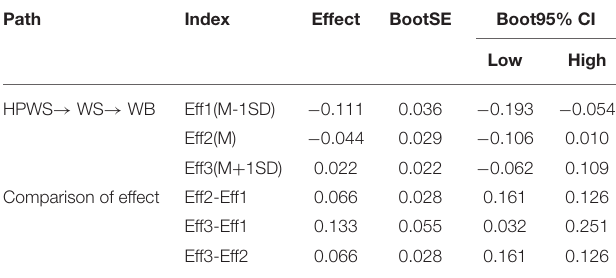
TABLE 5 | Moderated mediating effect.